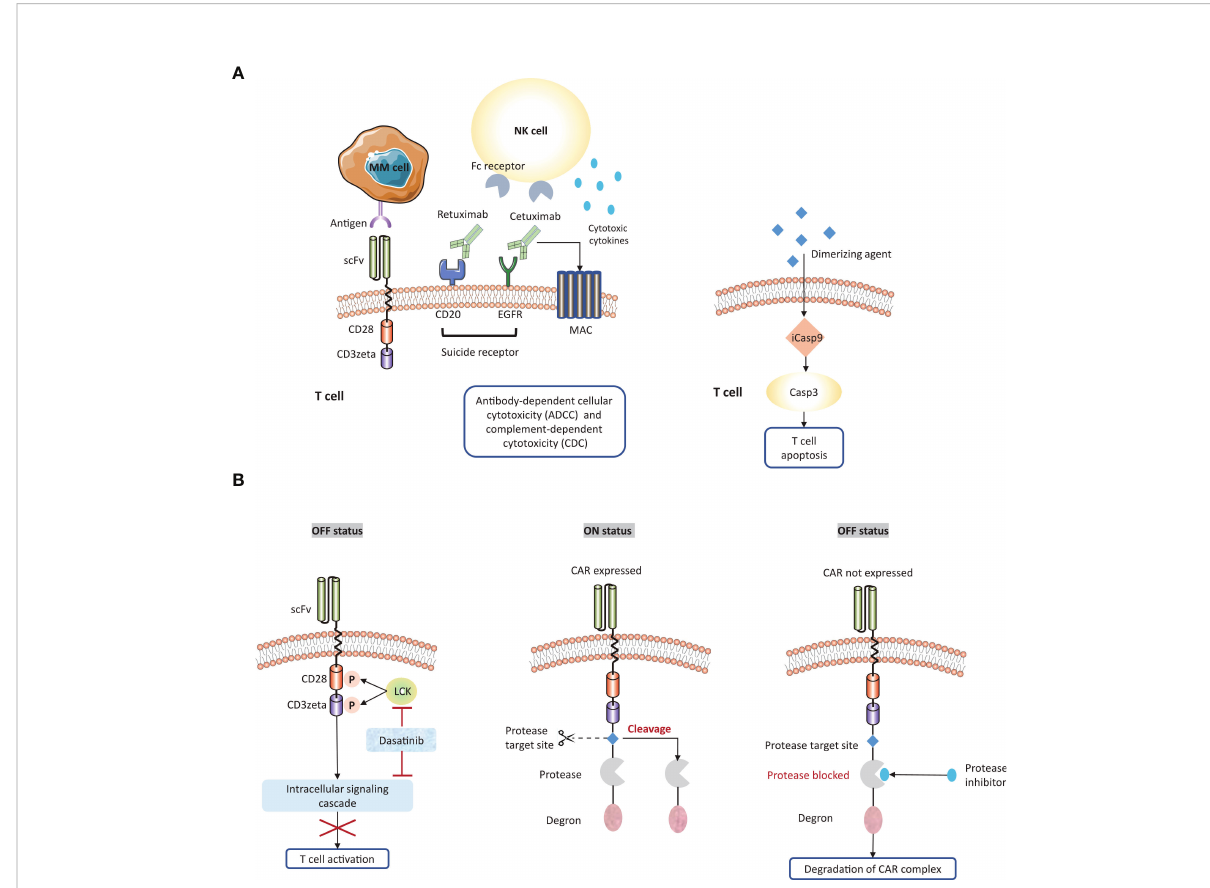
FIGURE 5 Strategies to overcome systemic cytokine toxicity. To counter systemic cytokine storm, several approaches are engineered to adjust CAR expression or activity. (A) Suicide gene system enables the elimination of CAR-T cells by following strategies: a) the activation of antibody- dependent cellular cytotoxicity (ADCC) or complement-dependent cytotoxicity (CDC); b) the induction of apoptosis pathway. (B) The ‘ ON/OFF switches ’ of CAR-T cells could be regulated by small molecular agents. scFv, single chain fragment variable; MAC, membrane attack complex; iCasp9, inducible caspase